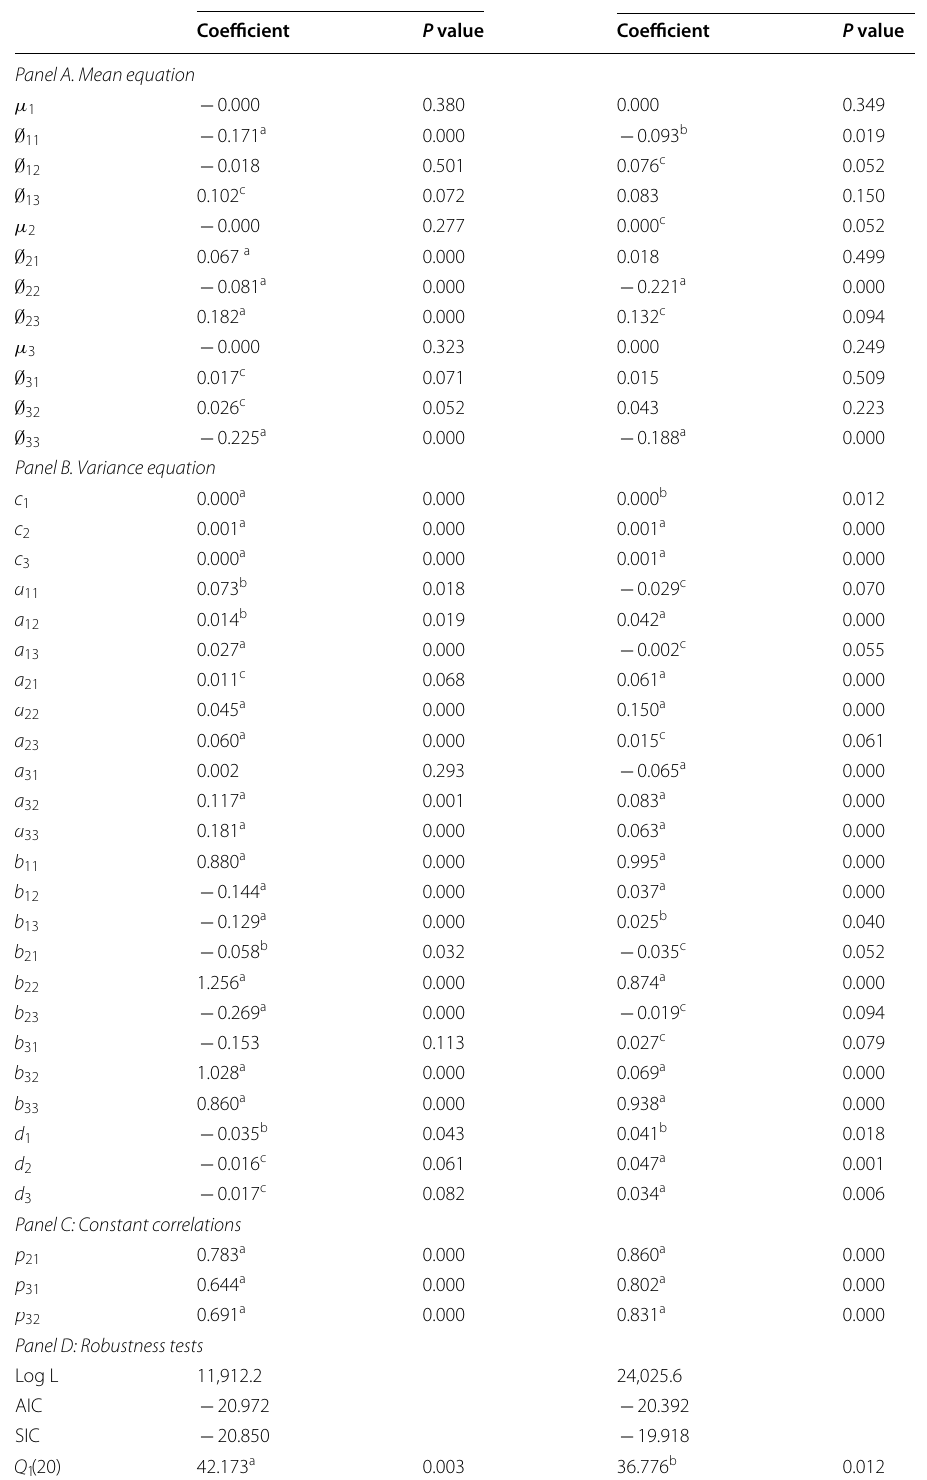
Table 3 Estimates of multivariate VAR-AGARCH model for the Bitcoin,